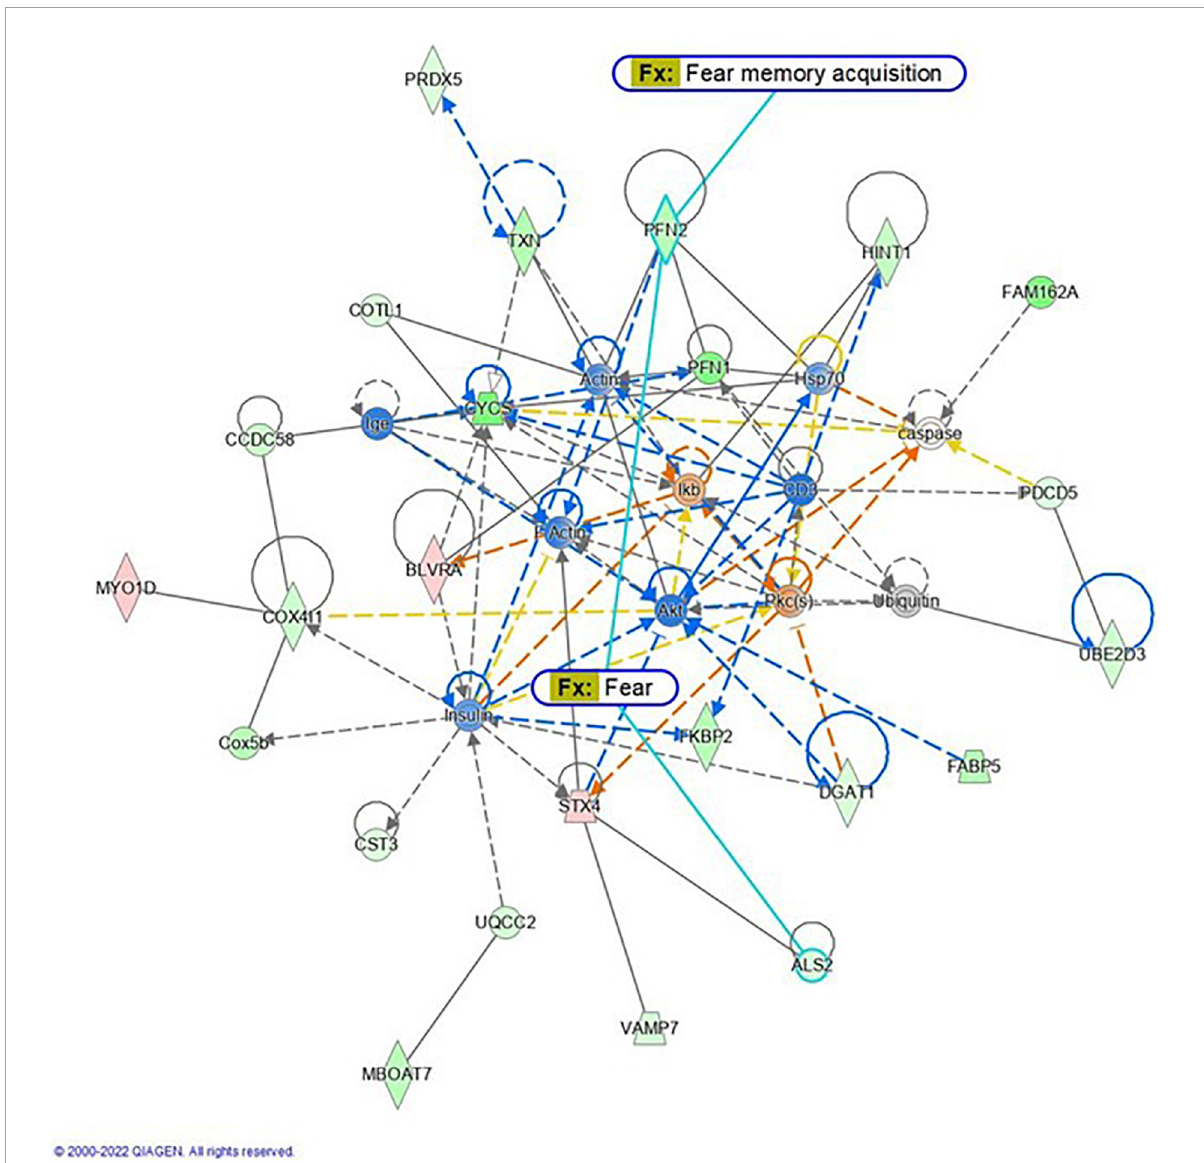
FIGURE7 Graphic representation of mouse hippocampus protein network 1, identified by Ingenuity Pathway Analysis (IPA) as being affected by sham irradiation compared to galactic cosmic rays (GCR) irradiation. Functions associated with the network include free-radical scavenging, cellular assembly and organization, and cellular function and maintenance. The network is overlayed with the disease and function tool to display the 2 key molecules involved with behavior. The node color indicates expression value, and color intensity indicates degree of up-or down-regulation: red indicates upregulation, and green indicates downregulation. Gray nodes are dataset molecules that were not significantly expressed and therefore did not pass the IPA analysis cutoff. Uncolored nodes were not part of our dataset but were incorporated into the pathway based on evidence stored in the Ingenuity Knowledge Base. Known direct and indirect interactions between network proteins, as well as the direction of the interaction, are indicated by arrows or blocked lines. Reproduced with a license obtained from